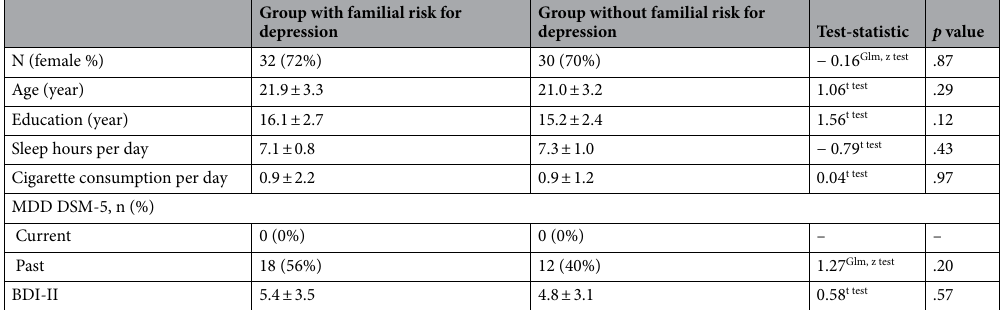
Table 2. Demographic and clinical characteristics in the two groups. Continuous data are mean ± standard deviation; Glm = generalized linear model with binomial error distribution, MDD major depressive disorder, BDI-II Beck Depression